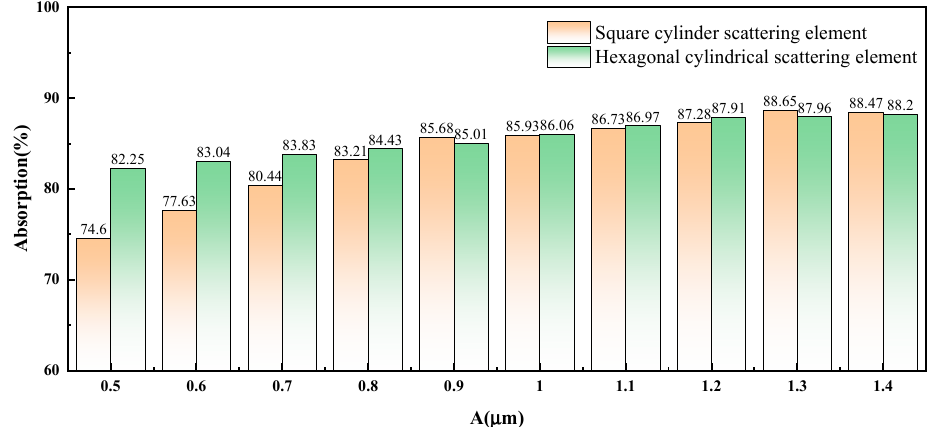
Figure 7. The effect of lattice constant A for two different types of scatterers on the absorption efficiency of the absorption layer.